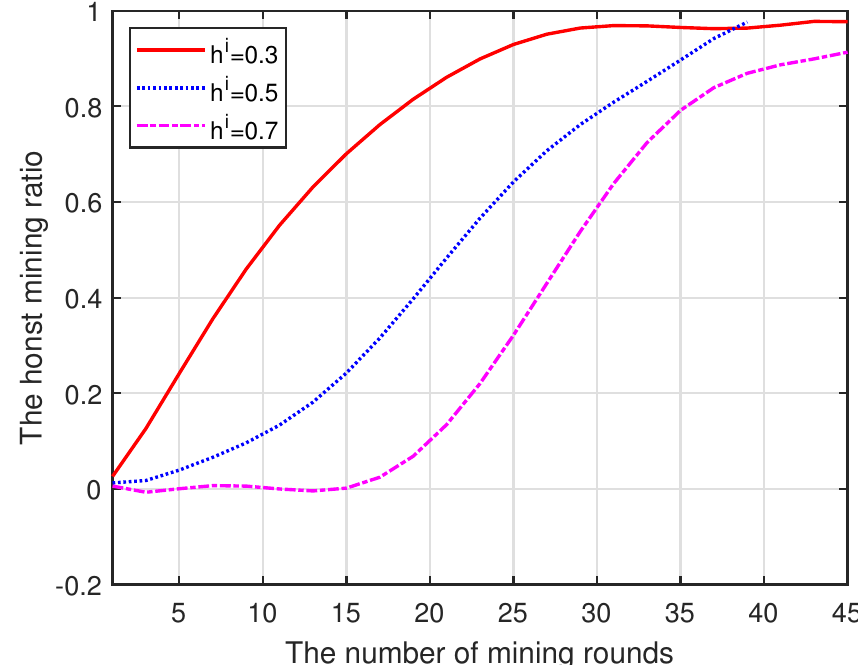
Figure 3. Mining rounds vs.